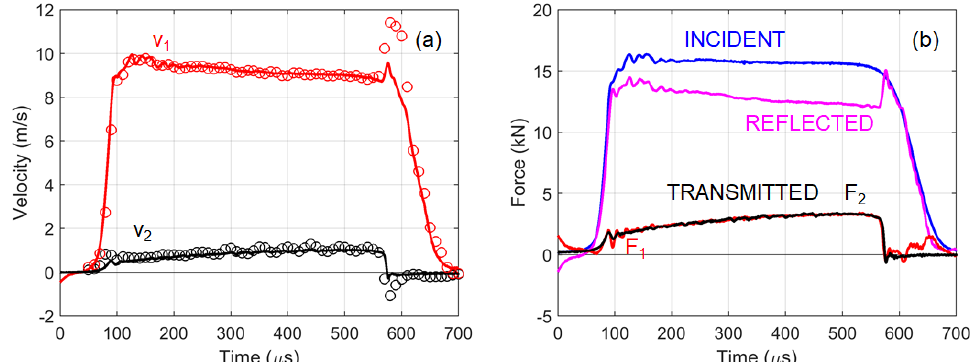
Figure 7. Results of a high strain rate test at 1000 °C: ( a ) comparison of the input (V 1 ) and output (V 2 ) sides’ velocity time history profiles obtained by video analysis (markers) and strain-gauge signal processing (solid lines); ( b ) check of the equilibrium condition in terms of forces on the input (F 1 ) and output (F 2 ) sides of the specimen.